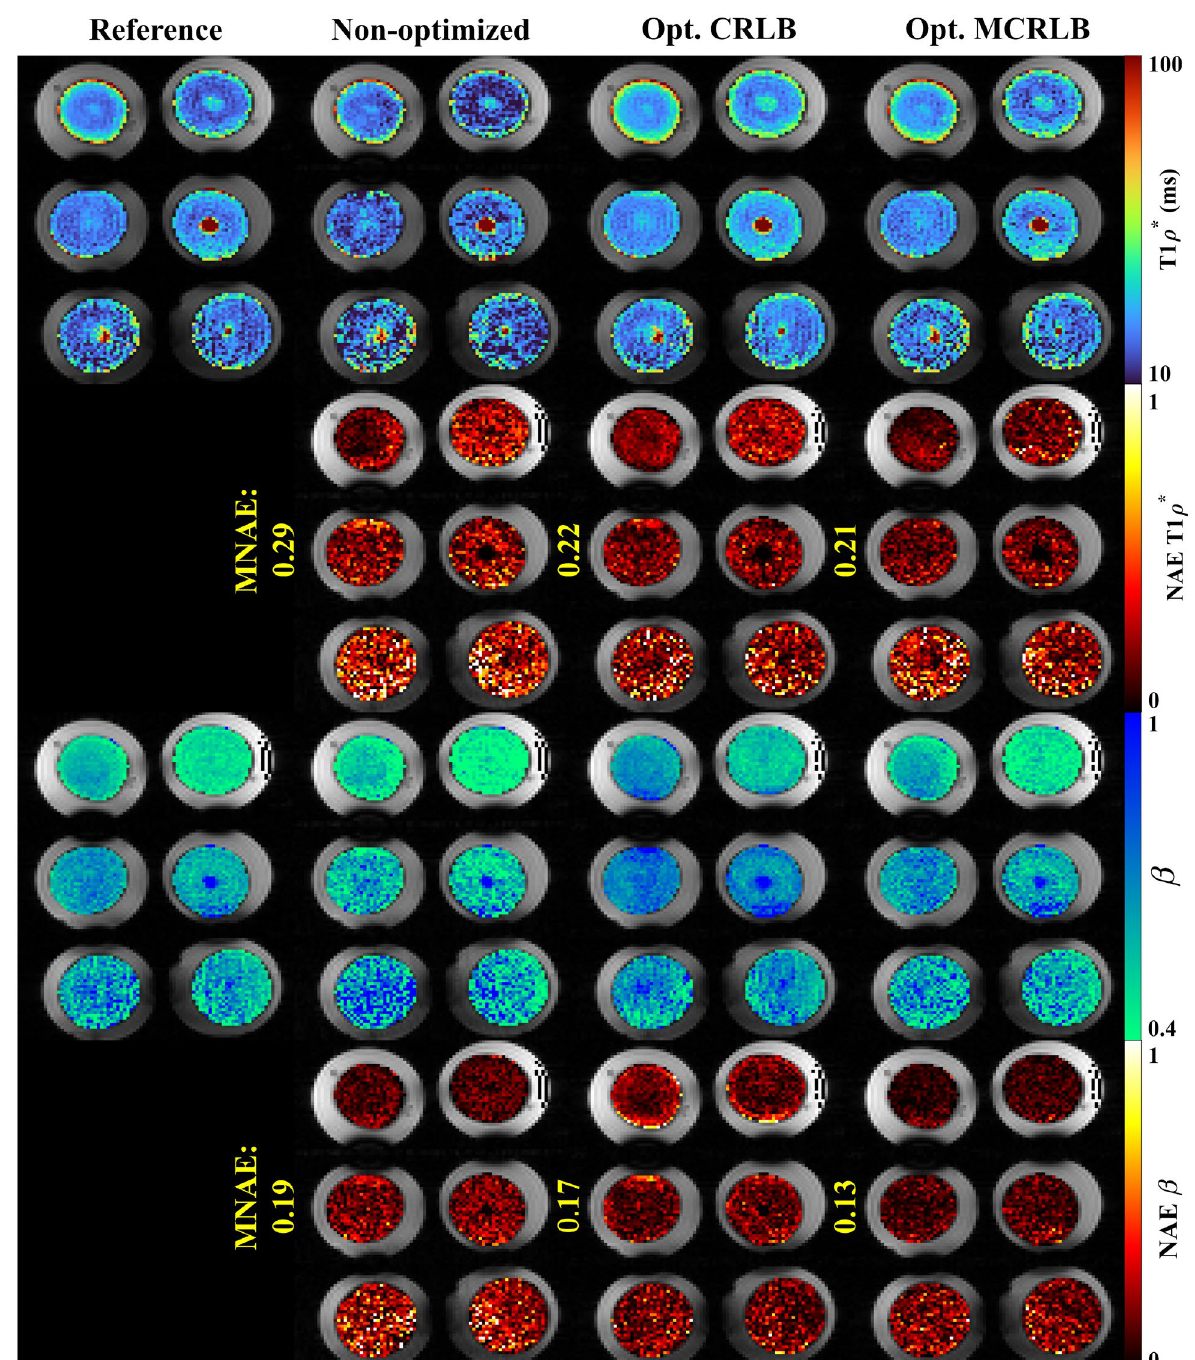
Figure 4. Stretched-exponential parameter maps for the egg yolk phantom. The parameters T 1ρ *, and β, along with the voxel-wise Normalized Absolute Error (NAE) for each parameter. Image created using Matlab 27 and Inkscape 28